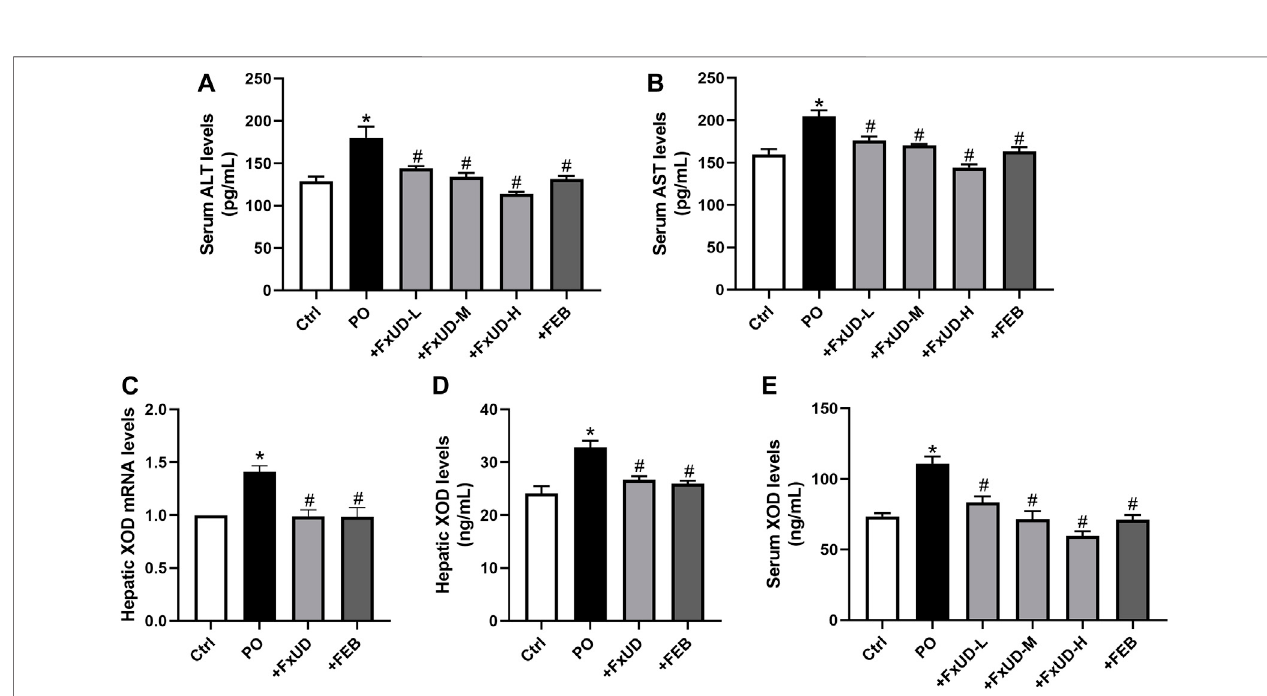
FIGURE 3 | Ameliorative effects of FxUD on changes of liver biomarkers and hepatic XOD in hyperuricemic mice. (A) ALT and (B) AST levels in mice serum as indicatorsofliverfunction( n (cid:1) 8). (C) XODmRNAexpression( n (cid:1) 5). (D) XODproteinlevelsintheliverweredetectedbyELISAkit( n (cid:1) 8). (E) XODinserumofmice( n (cid:1) 8). Values areexpressed as themeans ± SD. * p < 0.05 vs. Ctrl, # p < 0.05vs. PO. ALT, alanine aminotransferase; AST,aspartate aminotransferase; XOD, xanthine oxidase.